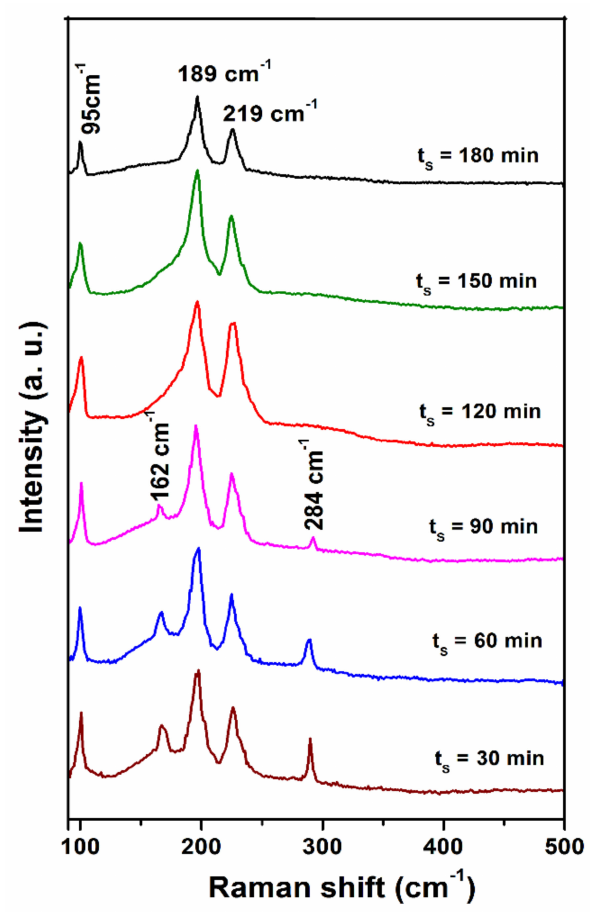
Figure 5. Raman spectra of sulfurized films at various sulfurization